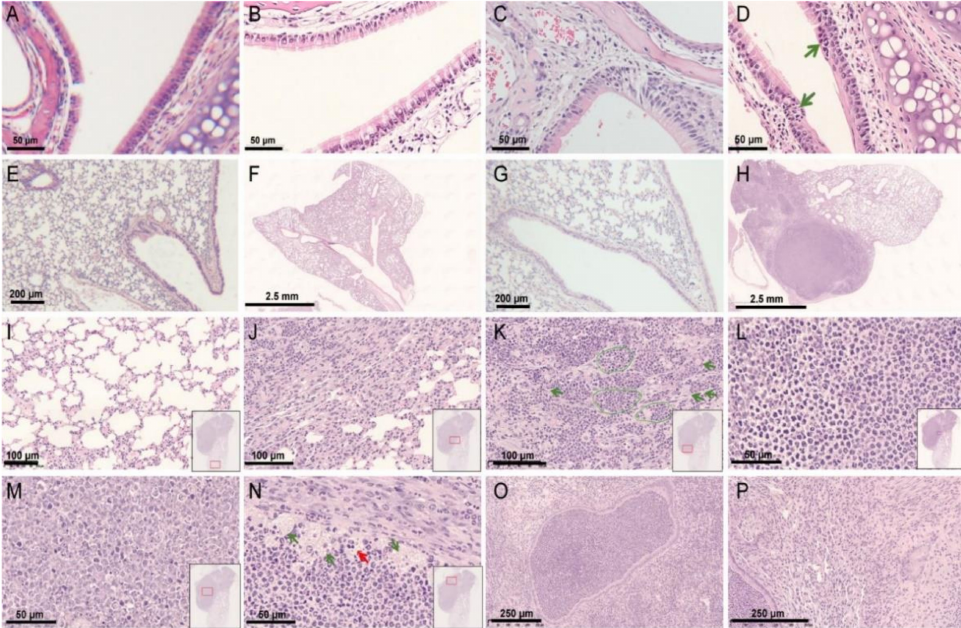
Figure 3. Histopathological findings in the respiratory tract of hRSV-infected Rag2 − / − mice. Hema- toxylin and eosin staining showed no obvious histopathological changes in the nasal tissue of wild-type mice inoculated with DMEM ( A ) or hRSV ( B ). ( C ) No obvious histopathological changes in the nasal tissue of Rag2 − / − mice inoculated with DMEM. ( D ) Degeneration of transitional epithelium and inflammatory cell infiltration observed in the nasal cavity of Rag2 − / − mice challenged with hRSV on 11 dpi. No obvious histopathological changes in the lung tissue of wild-type mice inoculated with DMEM ( E ) or hRSV ( F ) and Rag2 − / − mice with DMEM ( G ). ( H ) Part of the lung tissue of Rag2 − / − mice was basically normal (upper right), but severe suppurative bronchitis and bronchopneumonia were found in the left part of the lung on 11 dpi. ( I ) The basically normal area of the lung tissue of Rag2 − / − mice, indicated by the red rectangle in the insert in Figure 3I, similarly below. ( J ) The part of the lung tissue with infiltration of neutrophils. ( K ) Some alveoli (indicated by green circles) were filled with neutrophils, and some alveoli (indicated by green arrows) were severely compressed and deformed. ( L ) The bronchial lumen was filled with inflammatory cells (predominantly neutrophils). ( M ) There was a large number of degenerating and necrotic neutrophils in the central area of the bronchial lumen. ( N ) Enlarged and necrotic cells at the edge of the bronchial lumen (indicated by green and red arrows respectively). ( O ) Bronchial lumen filled with neutrophils, and the bronchial epithelium exists without obvious degeneration and shedding. ( P ) Enlargement of alveolar septa and interstitial inflammation including infiltration of monocytes and neutrophils in the lungs of Rag2 − / −